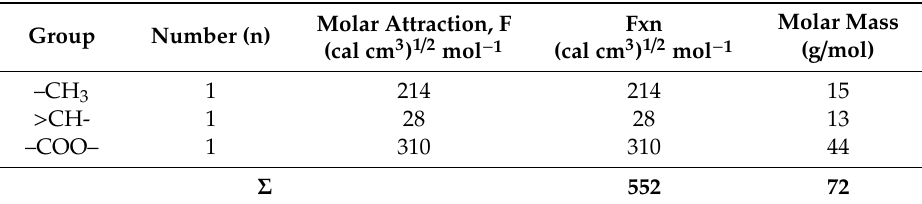
Table 1. Determination of solubility parameter of